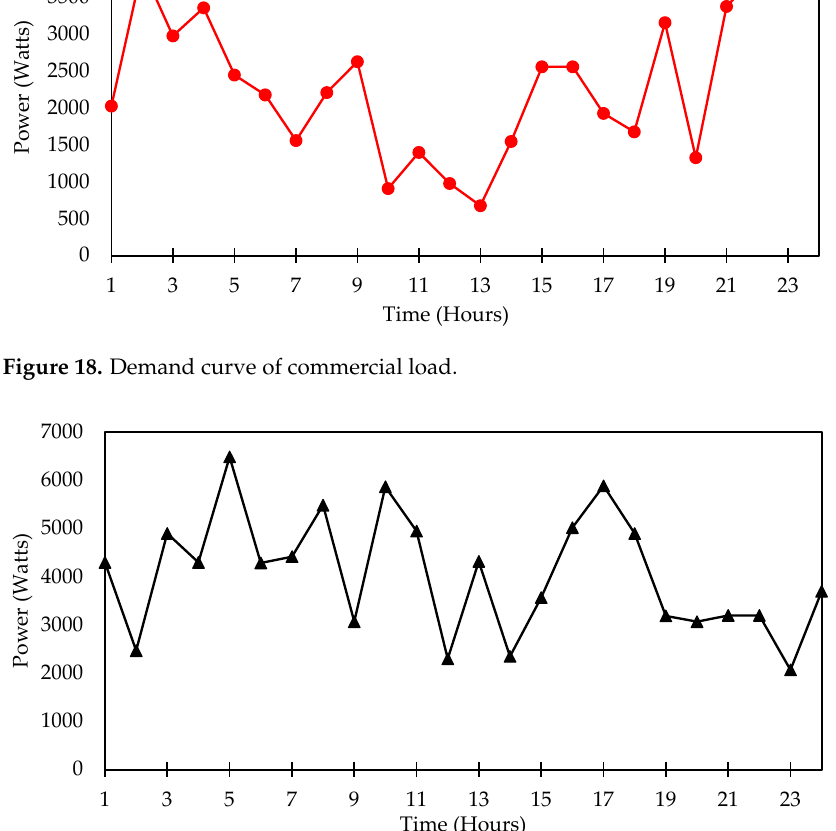
Figure 19. Demand curve of industrial load.